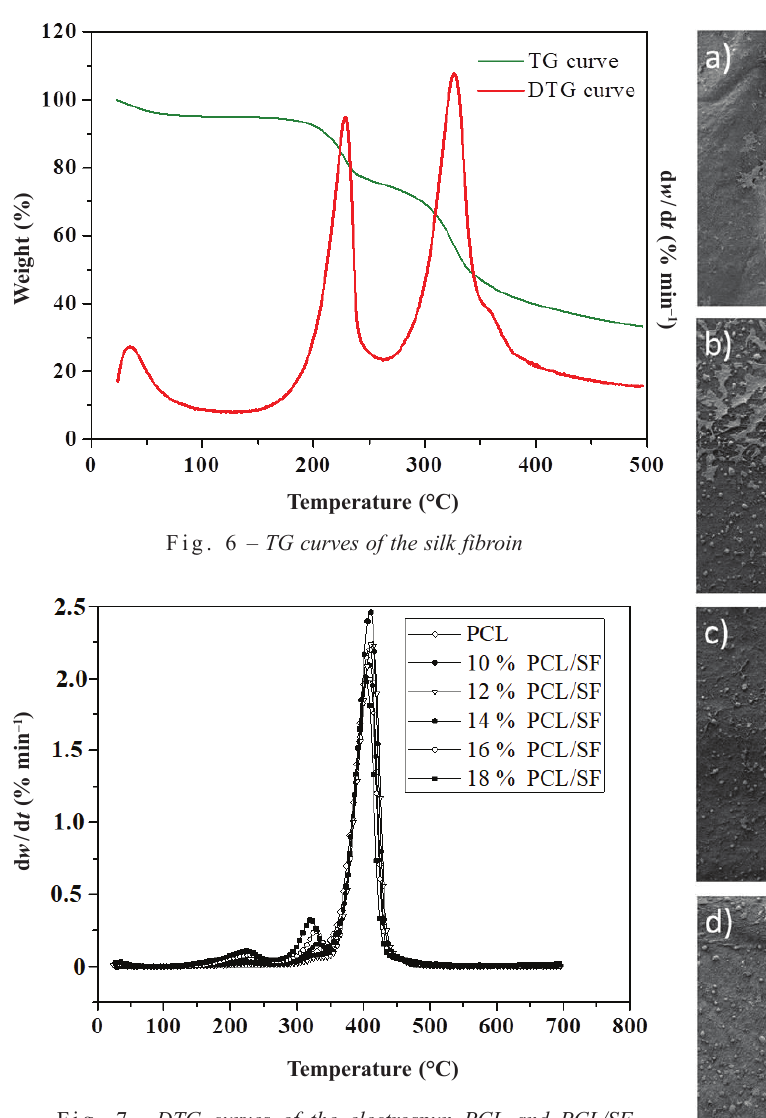
Fig. 7 – DTG curves of the electrospun PCL and PCL/SF scaffolds